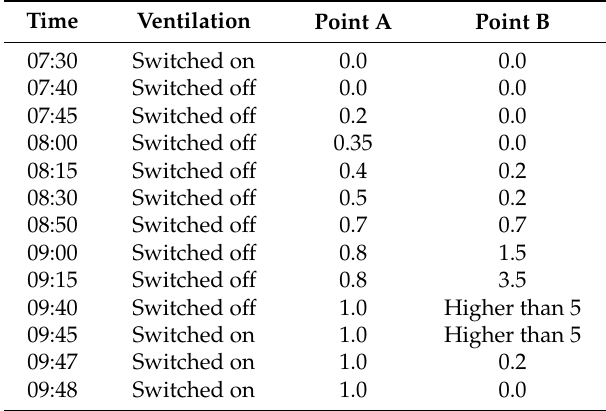
Table 1. Methane proportion